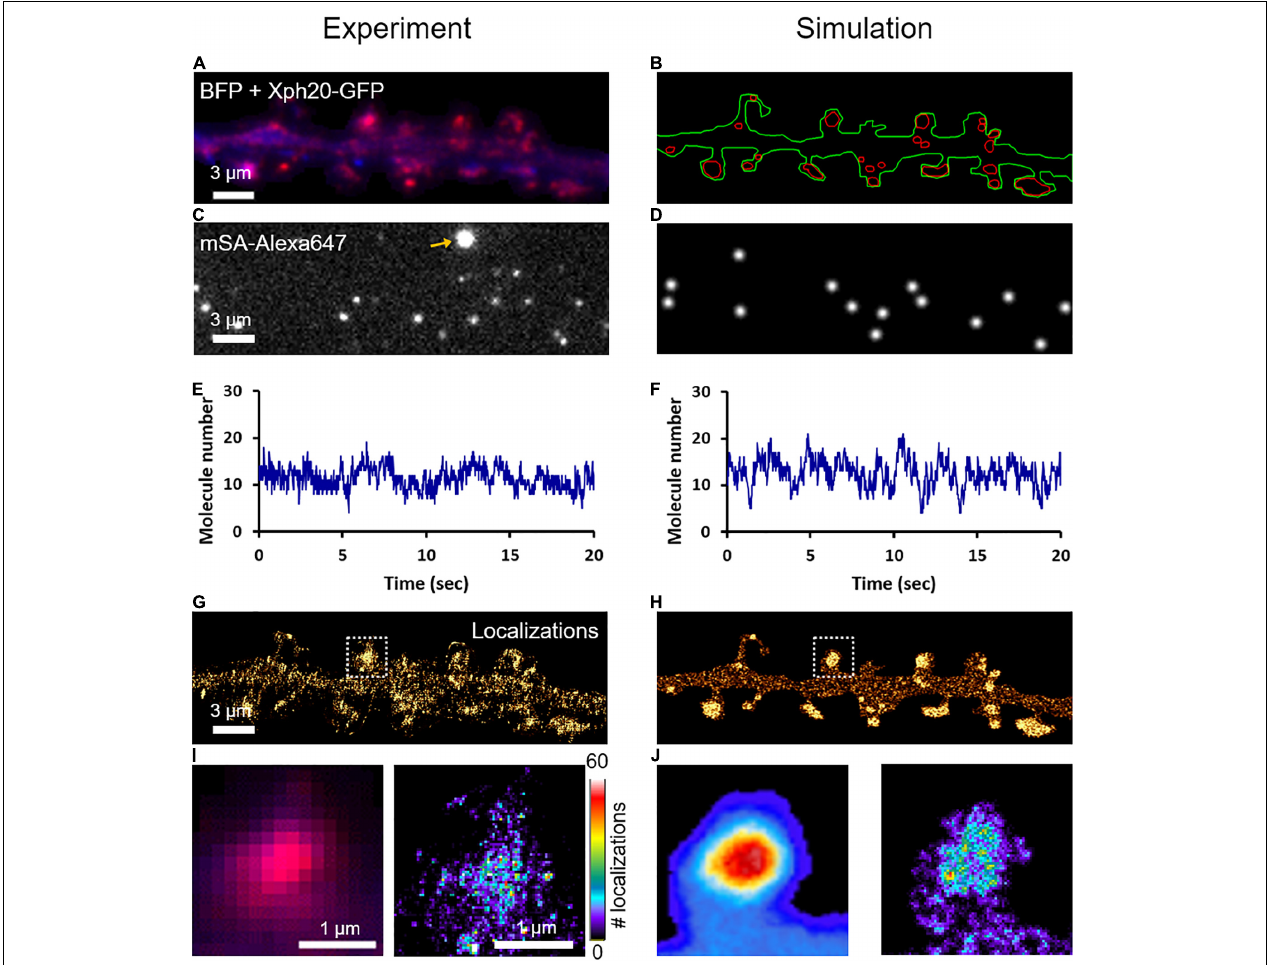
FIGURE 4 | Nanoscale organization of NLGN1 at synapses characterized by dSTORM. (A) Dual color image of a dendritic segment from a neuron co-expressing BFP (blue) + shRNA to NLGN1, AP-NLGN1, BirA ER , and Xph20-GFP (red). (B) The BFP and Xph20-GFP images, respectively, were used as reference to draw the dendrite outline (green) and the PSDs (red areas) entered in the simulator. (C) Representative single frame image of a dSTORM sequence performed on AP-NLGN1 labeled with Alexa647-conjugated mSA. The yellow arrow indicates a bright fluorescent bead used to correct for drift. (D) Simulated image showing single molecule fluorescence emission in the same cell geometry, each with a Gaussian intensity profile. (E,F) Number of single molecules per frame detected in the defined geometry for experiment or simulation, respectively, and plotted over time. (G) Experimental super-resolved image generated from 470,821 single molecule localizations (pixel size 32 nm, total acquisition time 800 s). Note the accumulation of NLGN1 in PSDs. (H) Simulated super-resolved map with a localization precision of 58 nm (FWHM). The total number of single molecule detections is 498,447. (I) Zoom on one dendritic spine showing the low resolution merged image between BFP (blue) and PSD (magenta), and the super-resolved dSTORM image of NLGN1 distribution in false color. (J) Simulated heat map images showing the low and high resolution images of NLGN1 accumulation in the PSDs of the same spine. The color code for the number of single molecule localizations per pixel applies to the right images of both panels (I,J)